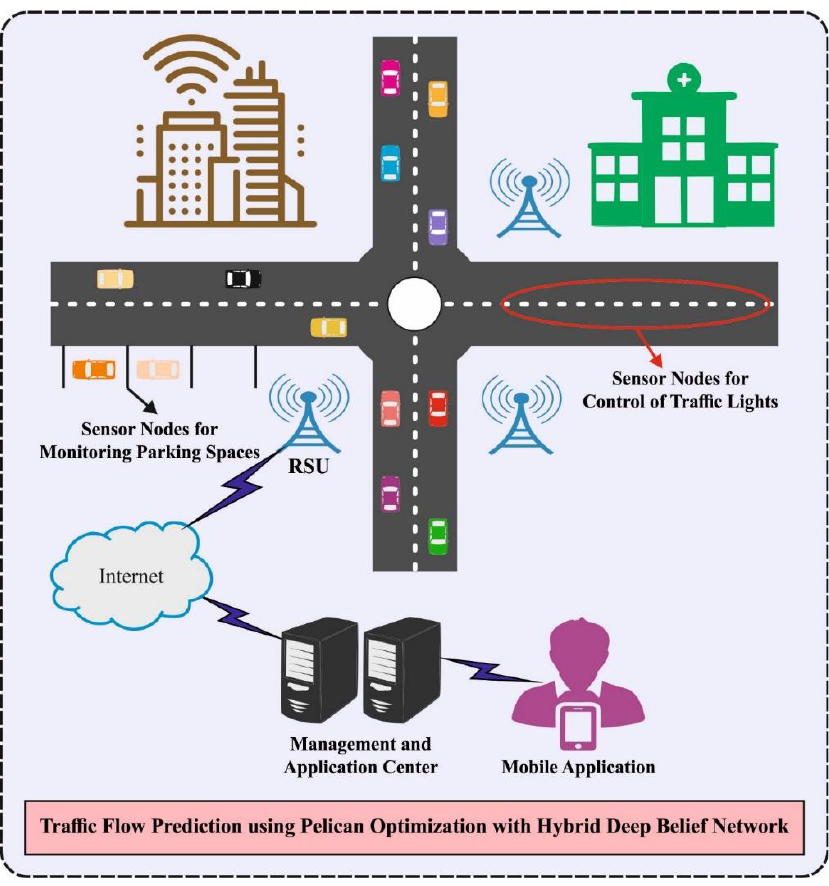
Figure 1. Overall process of proposed method.